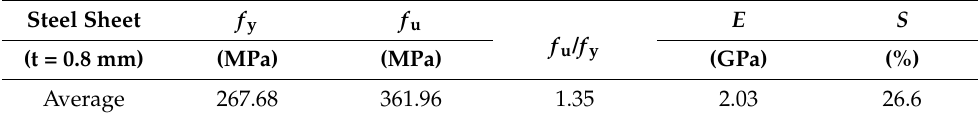
Table 4. Test results of material properties for the 0.8 mm steel sheets.